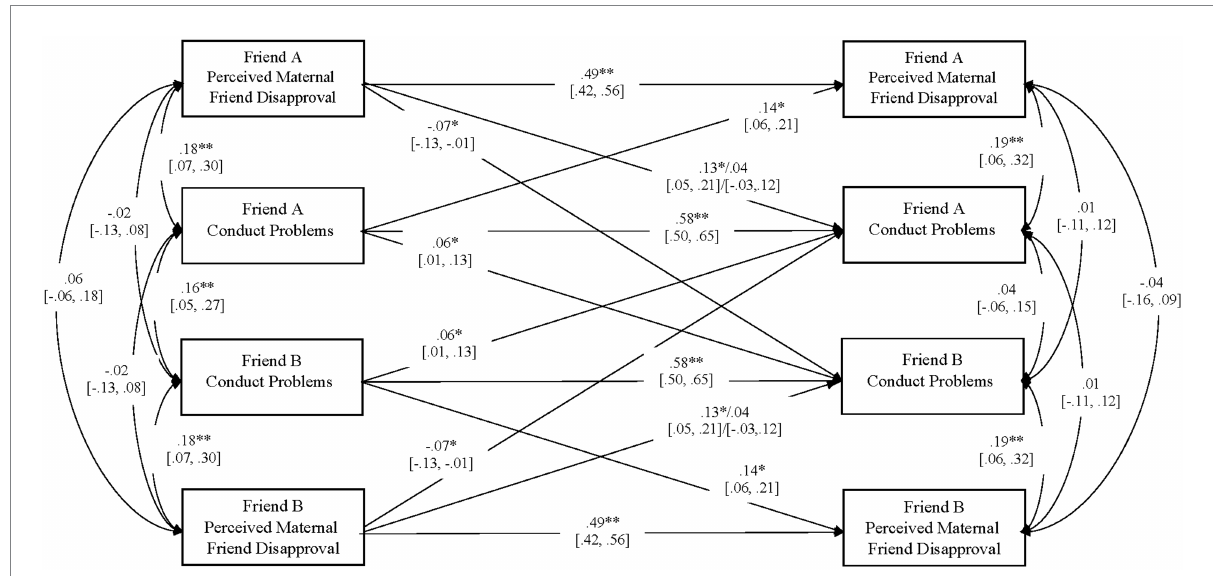
FIGURE 3 Longitudinal associations between friend externalizing symptoms and perceptions of material disapproval of friends. N = 142 dyads. For each paths, 95% confidence intervals are presented in brackets. Values to the left of the slash represent paths for boys and values to the slash represent paths for girls. **p < 0.01, * p < 0.05,